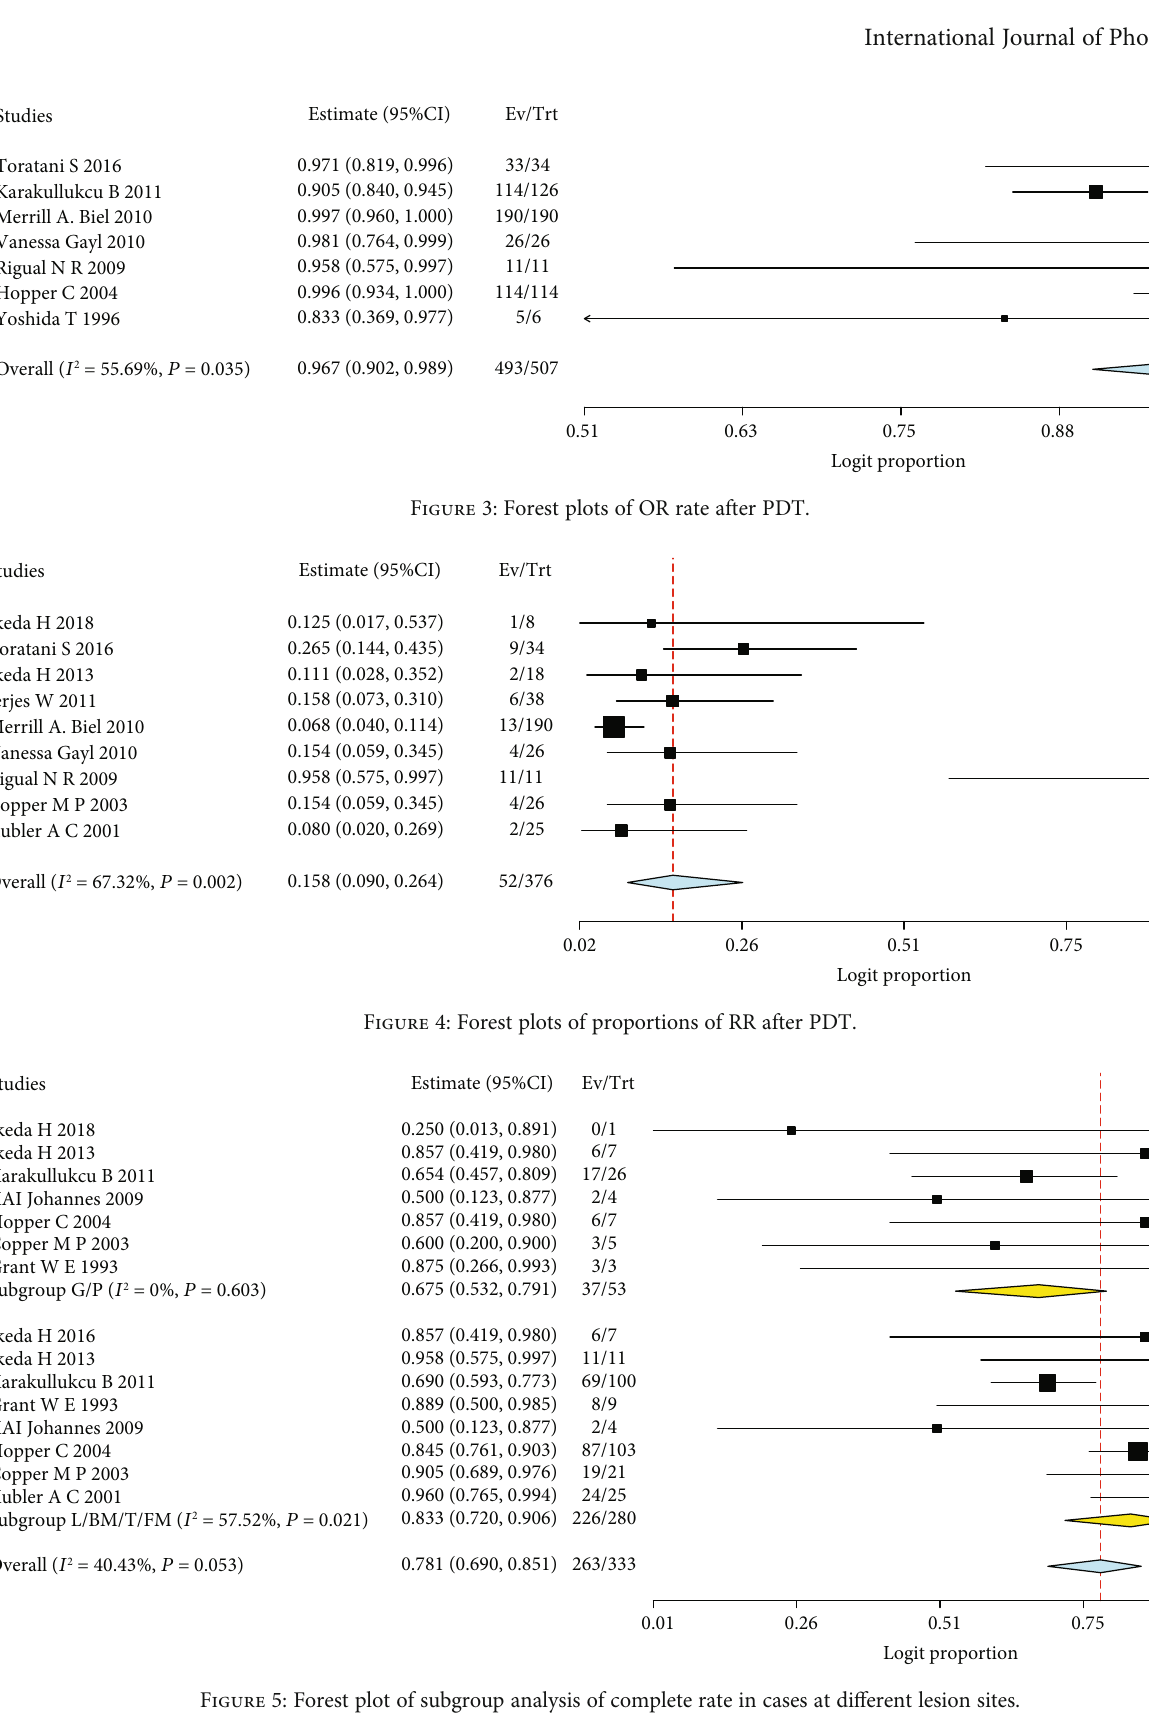
Figure 5: Forest plot of subgroup analysis of complete rate in cases at di ff erent lesion